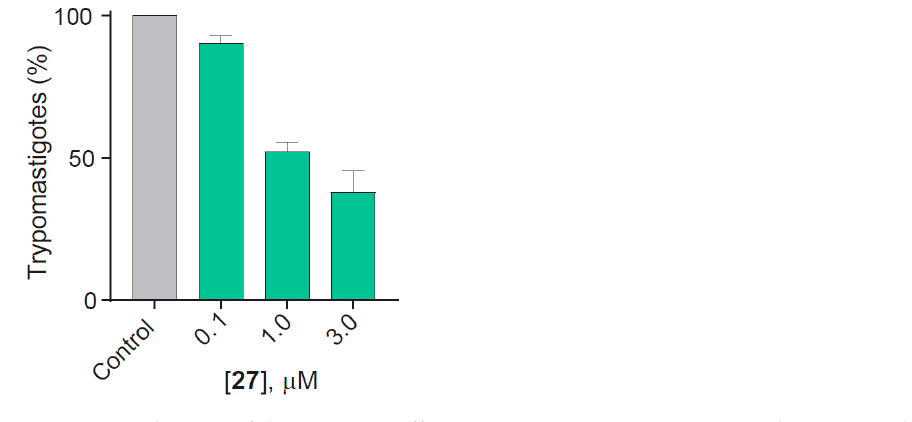
Figure 6. Evaluation of the cytotoxic effect on T. cruzi trypomastigotes with compound 27. The evaluation was done after 24 h of treatment.